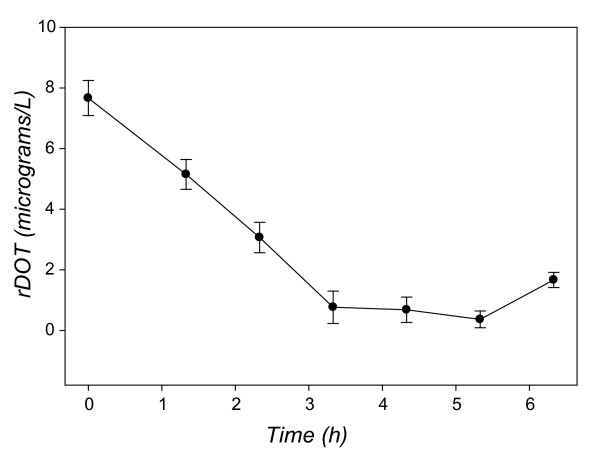
Residual dissolved oxygen (O2) in MOPS minimal medium. The mean rDOT was determined for three independent cultures of E. coli O157:H7 Sakai in glucose limited MOPS minimal medium and plotted with the error bars indicating the standard deviation.